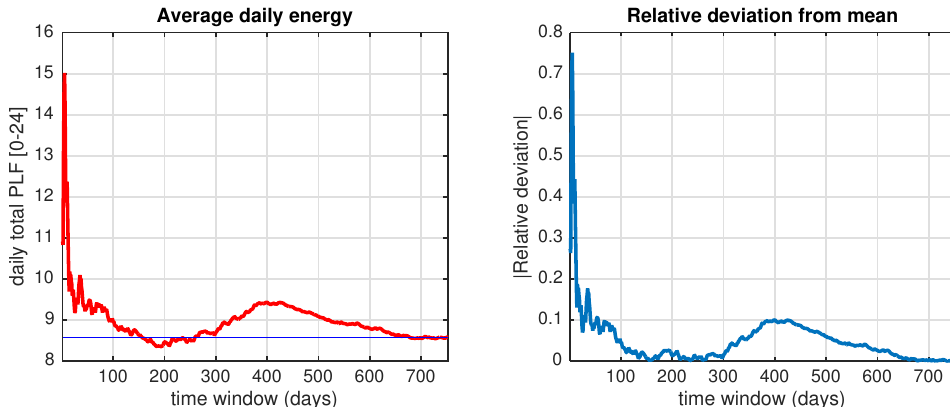
Figure 2. Total and relative deviations of actual PLF with respect to the historical average (leftmost horizontal blue line) as a function of the horizon (730 days).